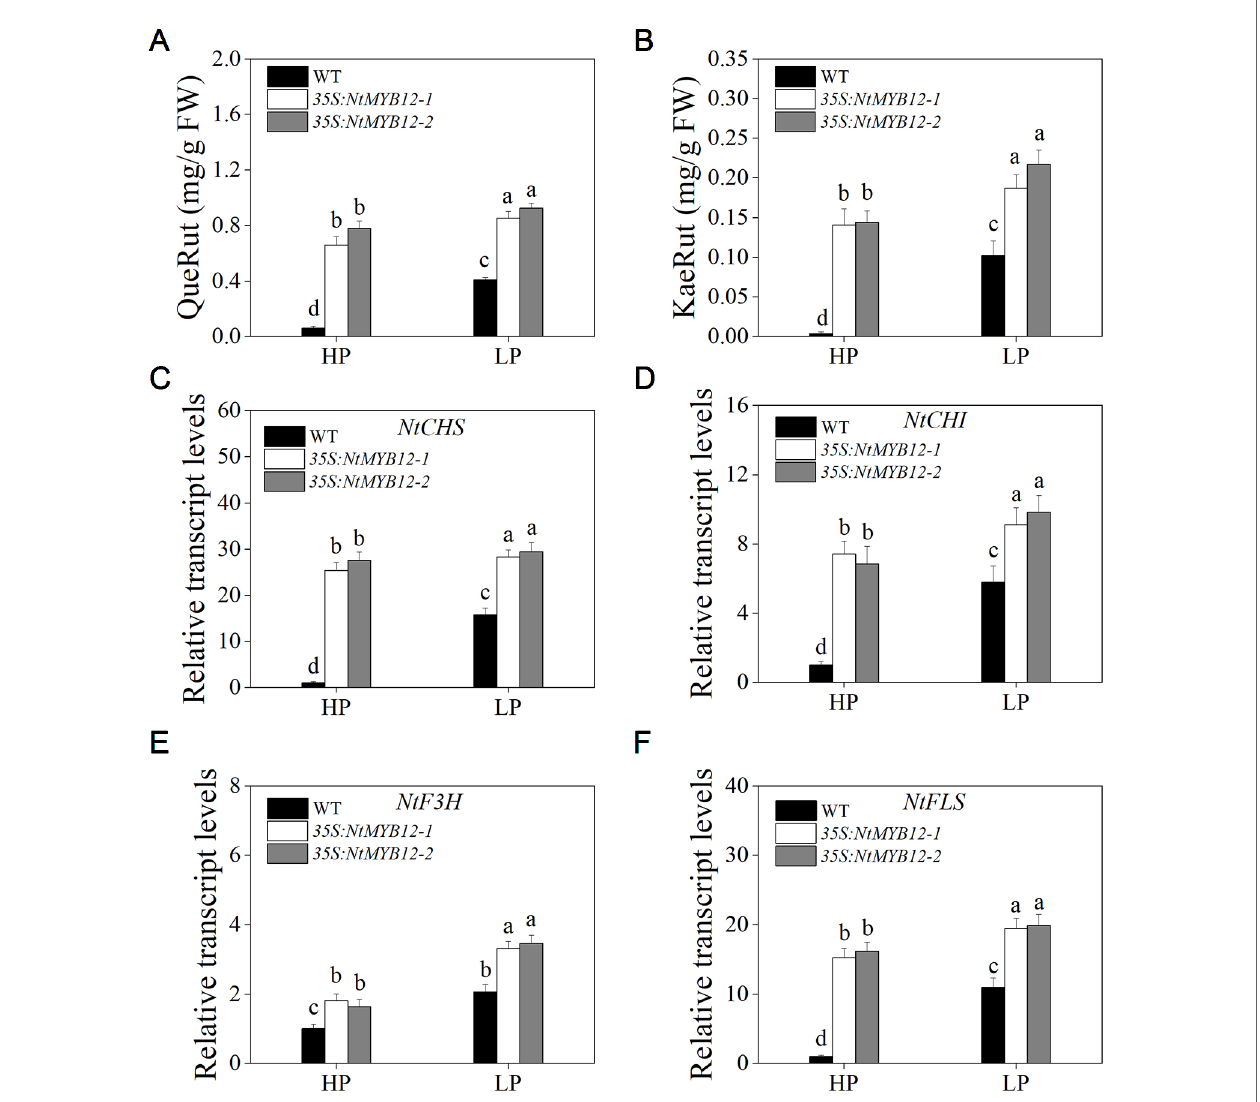
FIGURE 7 | Quanti fi cation of fl avonol concentration and relative transcript levels of majority genes encoding fl avonoid biosynthetic enzymes in WT and 35S: NtMYB12 plants under HP and LP conditions. (A – B) QueRut and KaeRut concentrations of WT and overexpression tobacco plants. (C – F) Effect of NtMYB12 overexpression on relative transcript levels of fl avonol biosynthetic genes in tobacco. Sixteen-day-old seedlings were transferred to the full-strength culture solution and supplied with high Pi (HP; 1mM Pi) or low Pi (LP; 0.02mM Pi) for 21 days. The whole plants of the WT and transgenic plants were used for RNA extraction. FW, fresh weight; CHS , chalcone synthase; CHI , chalcone isomerase; F3H , fl avanone 3-hydroxylase; FLS , fl avonol synthase. Data are the means ± SDs of fi ve biological replicates. Different letters indicate signi fi cant differences ( P <